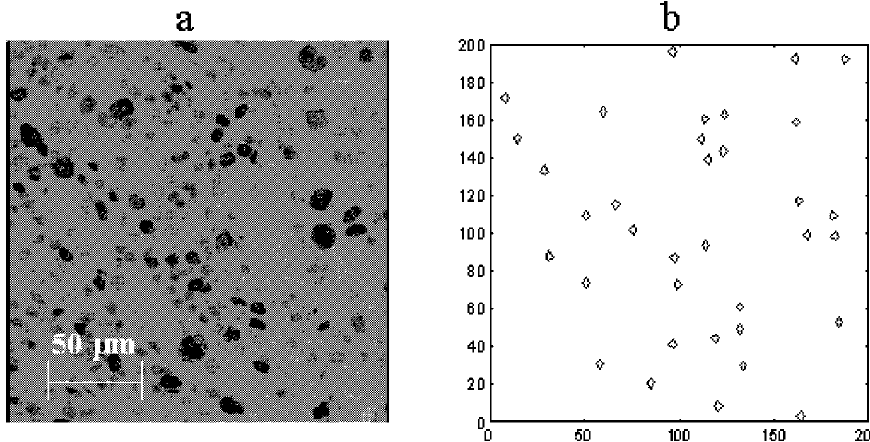
Fig. 1. Peroxidase MIB-1 labelling of nuclei: (a) histological image of breast carcinoma labelled with MIB-1; (b) nuclear centroid positions obtained by semi-automatic image